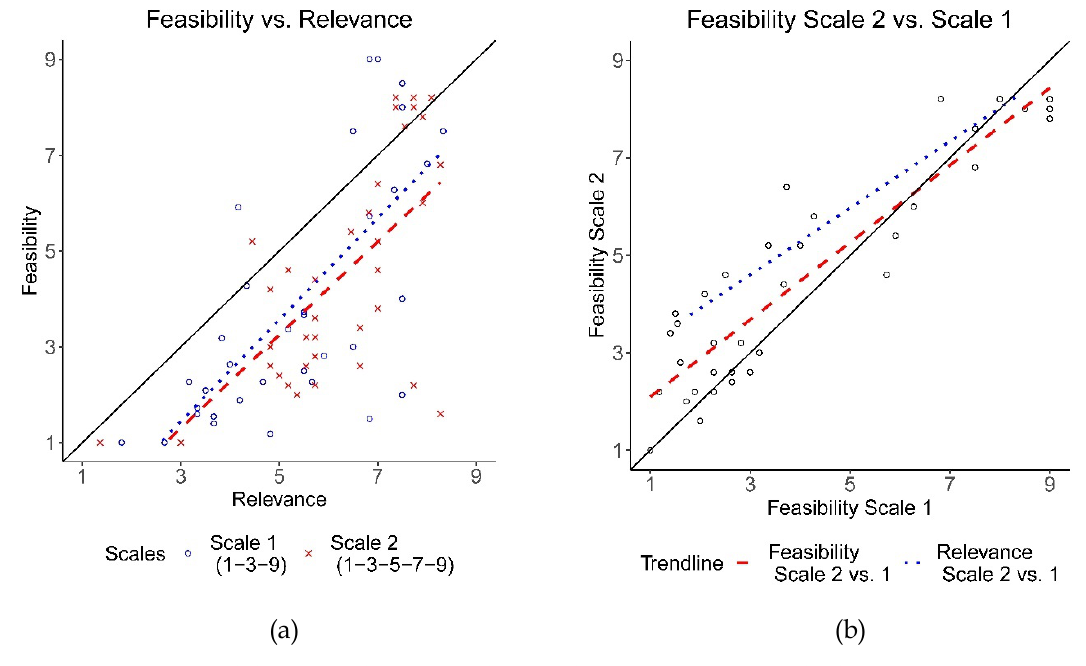
Figure 4. Feasibility and relevance analysis including a 45–degree solid line A plot of feasibility and relevance is shown in Figure 4(a) shows the trend in this relation for both rating scales: 1 (1-3-9) and 2 (1-3-5-7-9), where feasibility is almost lower than relevance; the former scale is based on the method by Hunt (2015), while the latter aims to give a rather uniform ordinal scale with the same range (1–9). It can be noted that the linear regression for the first scale (solid line) is higher than that of the second scale (dashed line); this is mostly observed for the